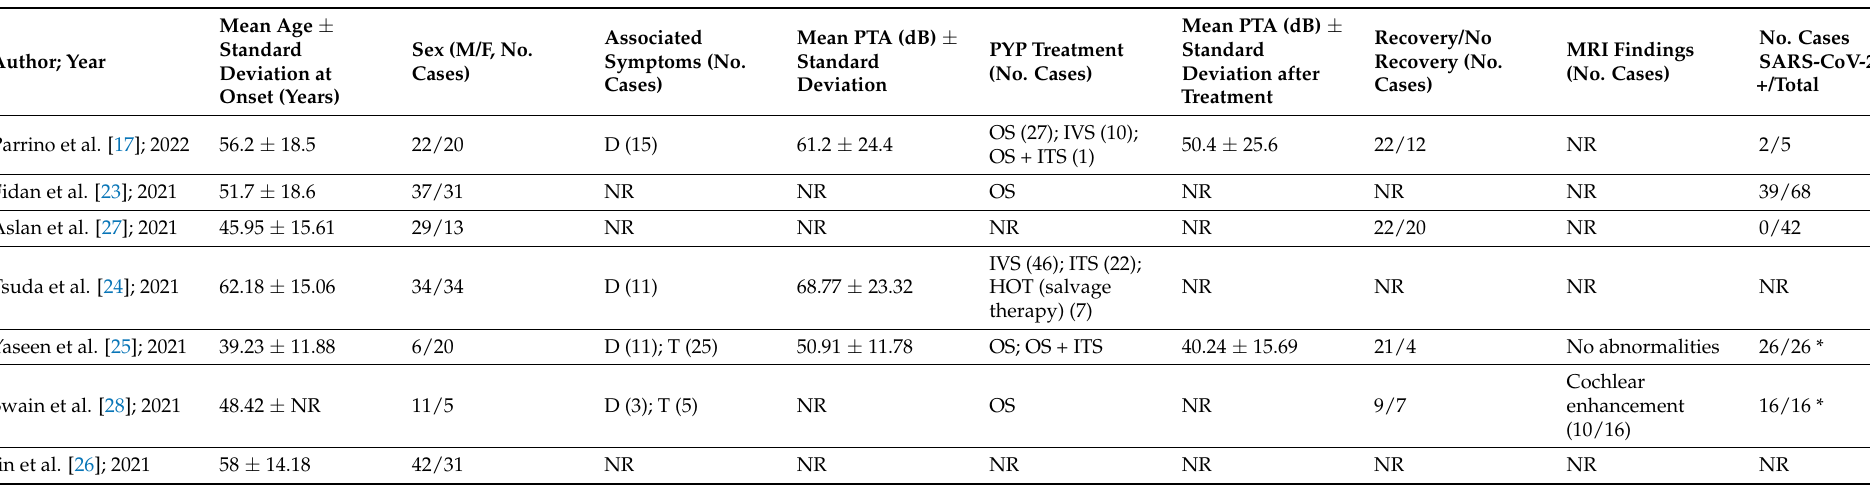
Table 2. PYP demographic and clinical information, PTA, administered treatment, and SARS-CoV-2 swab results.